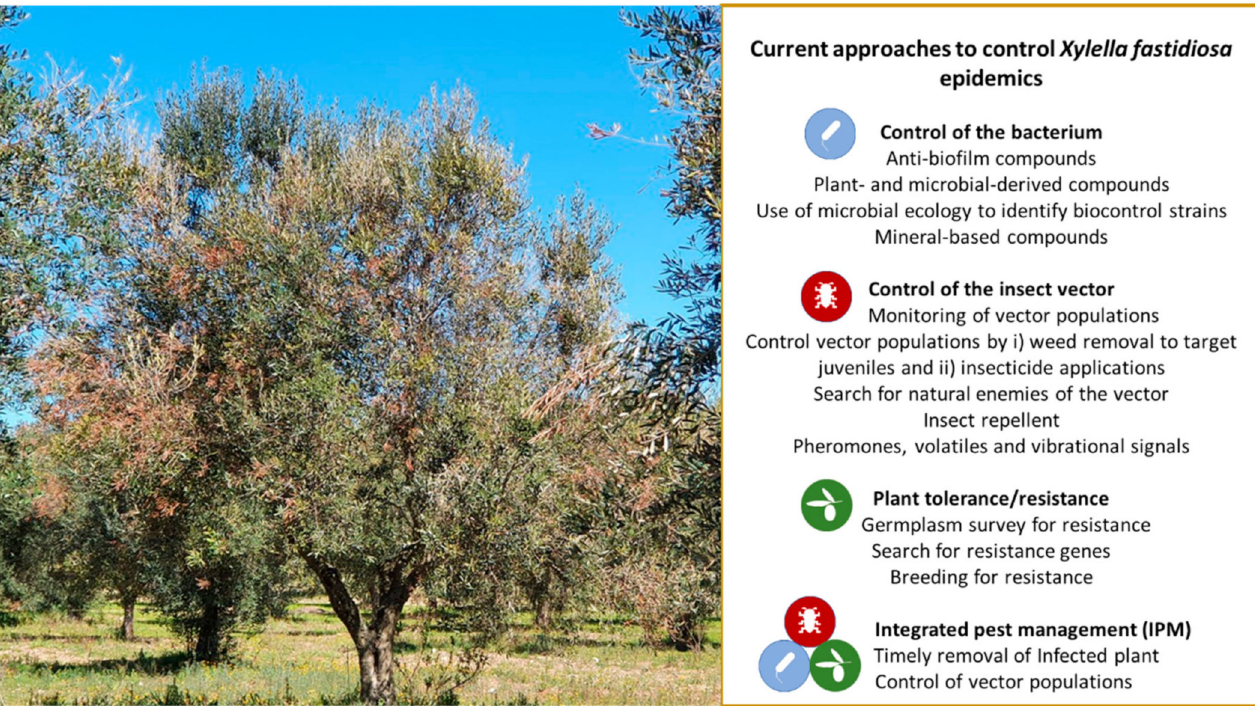
Figure 2. Current approaches to control Xylella fastidiosa